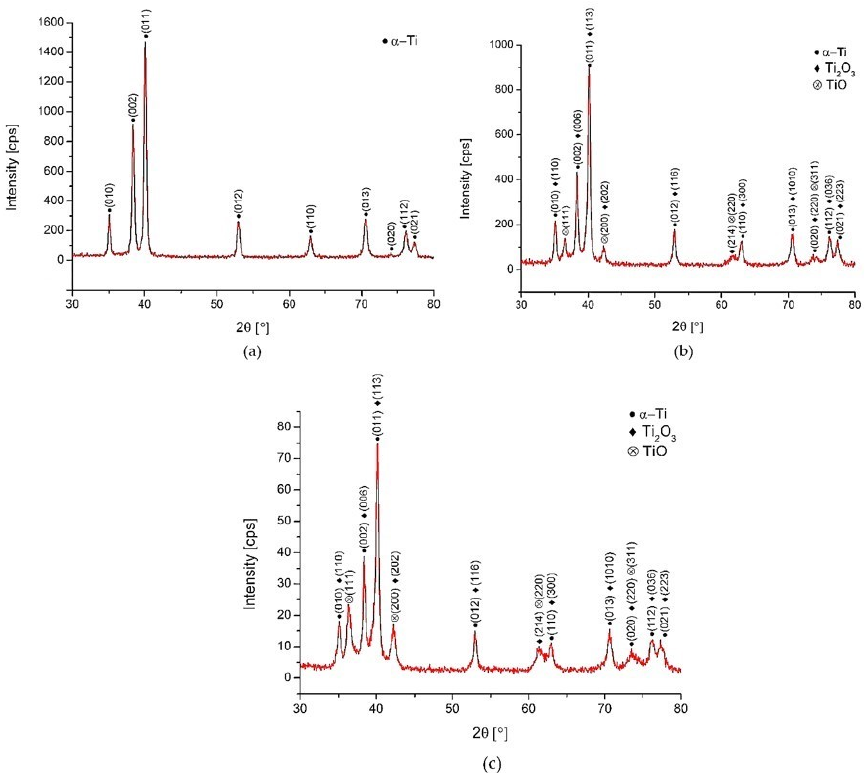
Figure 7. XRD patterns. ( a ) as-received surface, ( b ) Surface A, ( c ) Surface